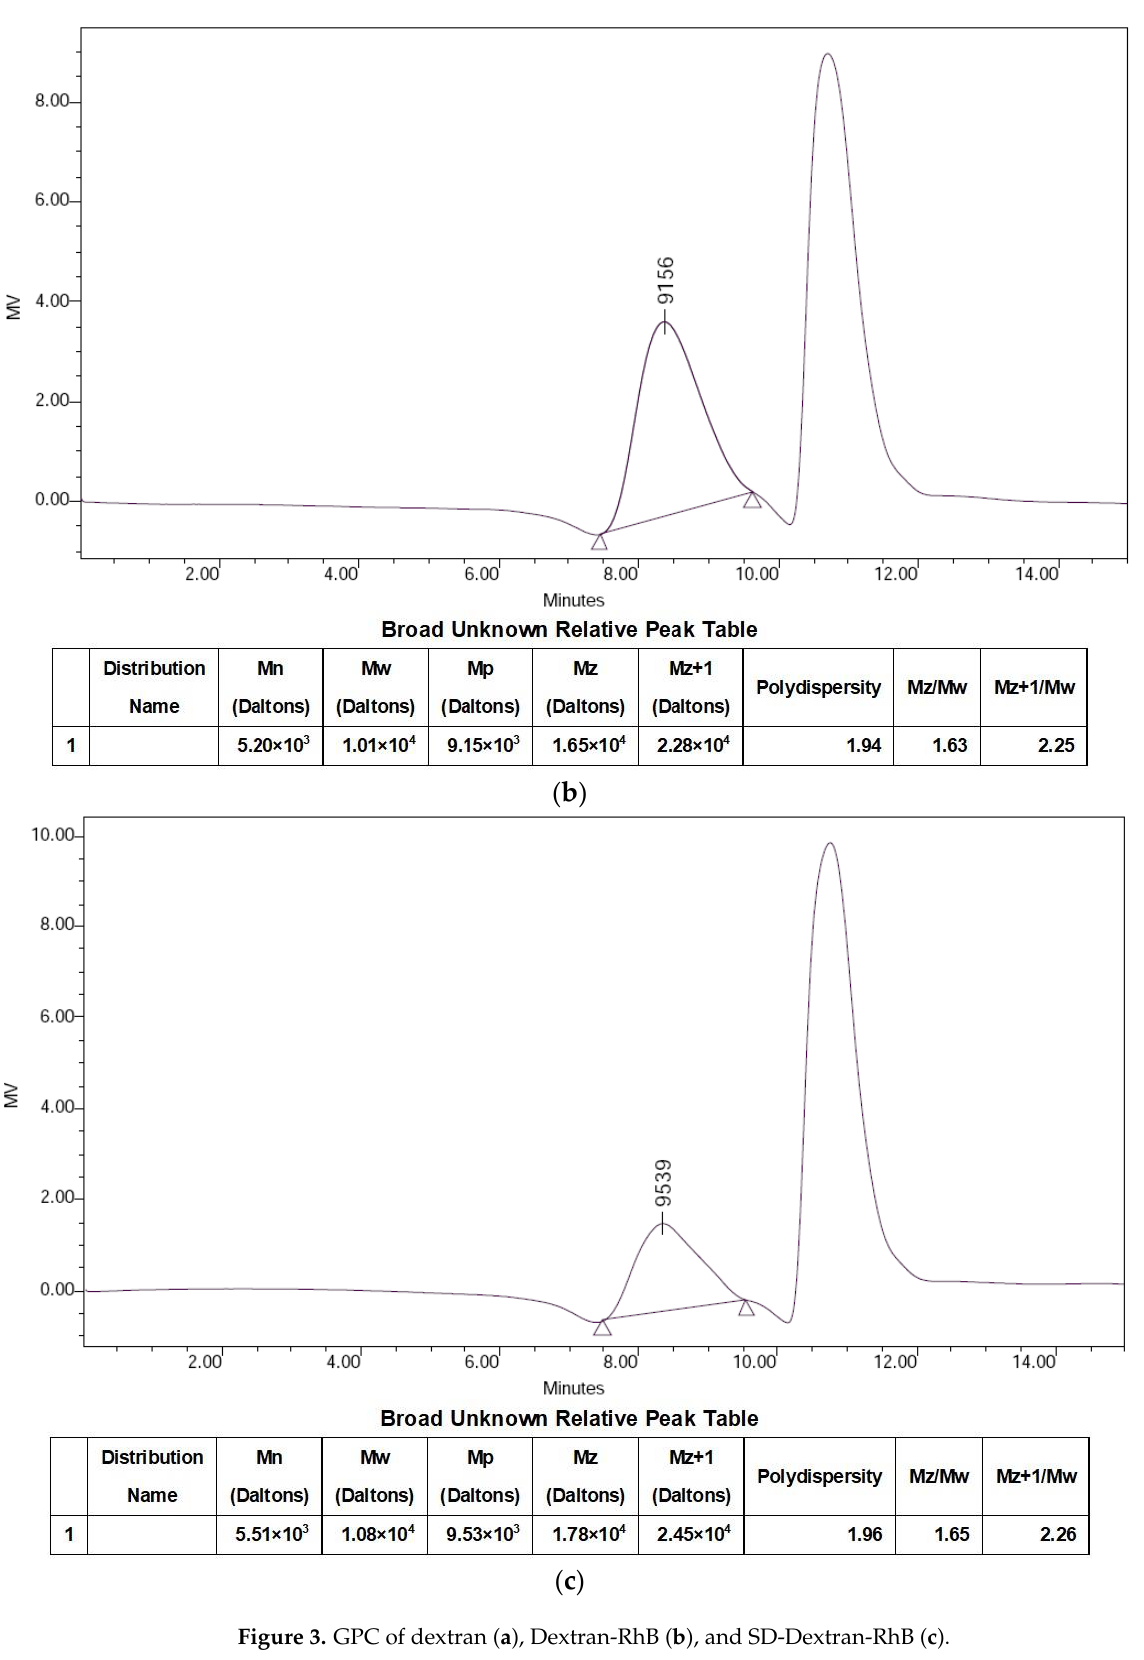
Figure 3. GPC of dextran ( a ), Dextran-RhB ( b ), and SD-Dextran-RhB ( c ). The molecular weight was measured using gel permeation chromatography (GPC). The first peak presented the normal average number weight of the sample. The other peaks appeared at the last period and eluted from GPC column later, which also presented the solvent of water. Average number molecular weight (Mn) of SD-Dextran-RhB was 5.51 × 10 3 and the polydispersity index was 1.96 (Figure 3). The molecular aggregation struc- ture of SD-Dextran-RhB in the solution changed due to the attachments of RhB and SD to